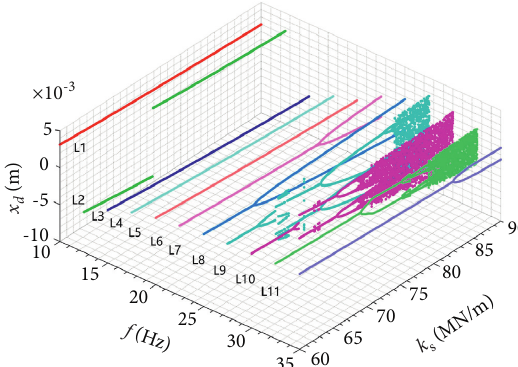
Figure 13: Bifurcation diagrams with the subgrade stiffness k bifurcation parameter under different excitation frequencies � 1 . 5mm and c � 130kNs/m). ( A s 0